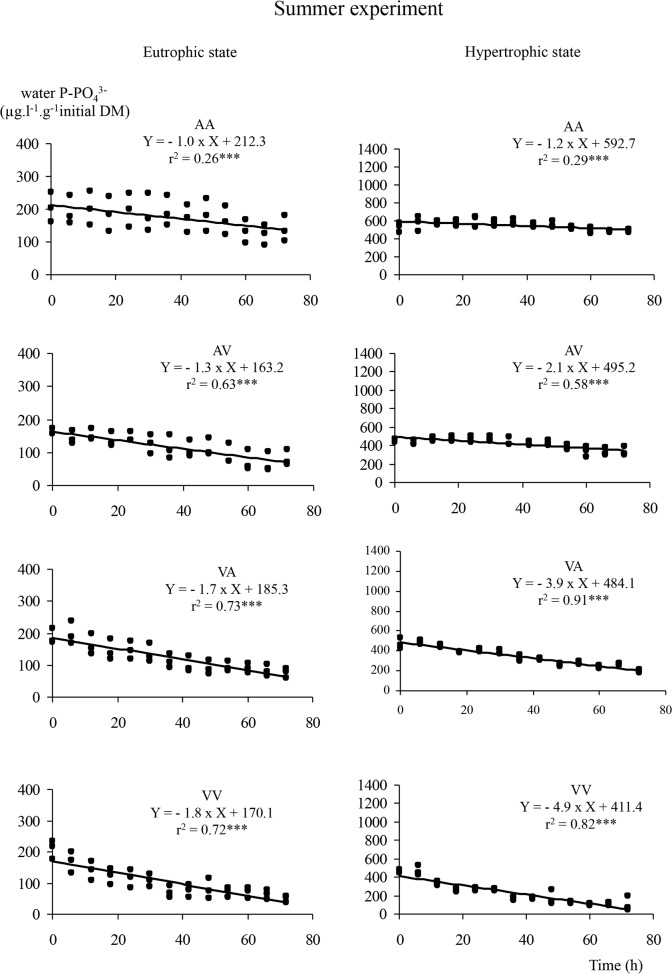
Dynamics of water phosphorus in summer.Dynamics of water phosphorus (in μg.l−1.g−1 of plant initial dry mass) and results of a linear model regression analyses under eutrophic and hypertrophic conditions, for all the possible combinations of water and subpopulation, during the summer experiment. In the legend, AA, AV, VA, VV include the information on the treatment, the first letter refers to the type of water and the second one to the subpopulation (e.g. AV means Alsatian water and Vosgian subpopulation).